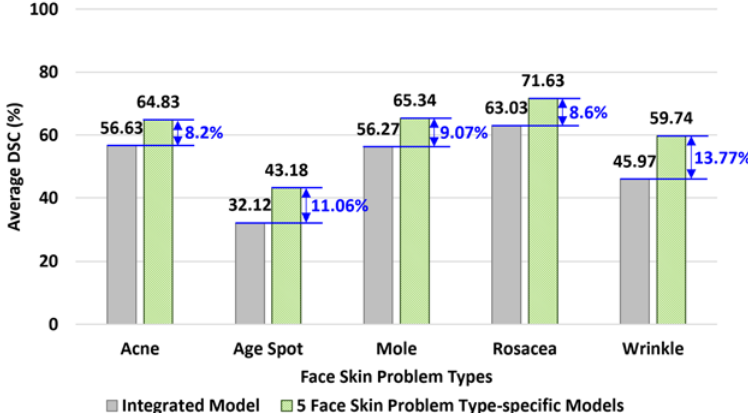
Figure 16. Comparing performance of integrated model and facial skin problem type-specific